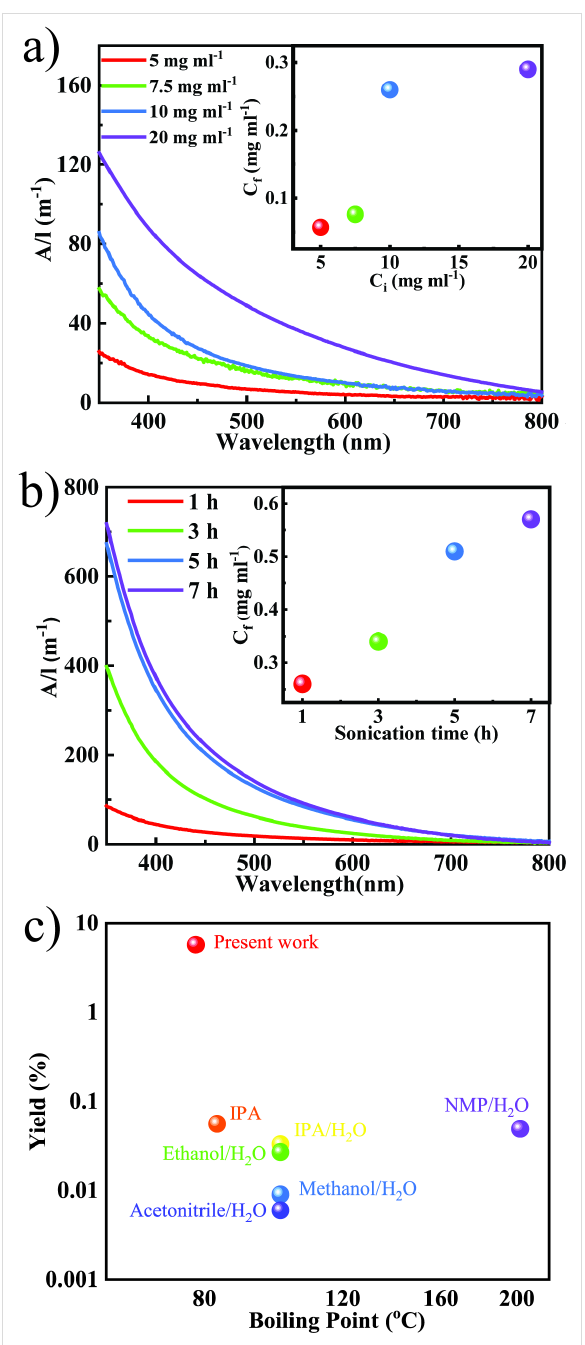
Figure 1: (a) UV–vis spectra of MoO 3 dispersions obtained from differ- ent initial concentrations ( C i ). The inset shows the final concentration as a function of the initial concentration; (b) UV–vis spectra of MoO 3 dispersions obtained from C i = 10 mg·mL − 1 after different sonication durations. The inset shows the final concentration as a function of the sonication time; (c) comparison of previously reported MoO 3 disper- sion yields in different solvents